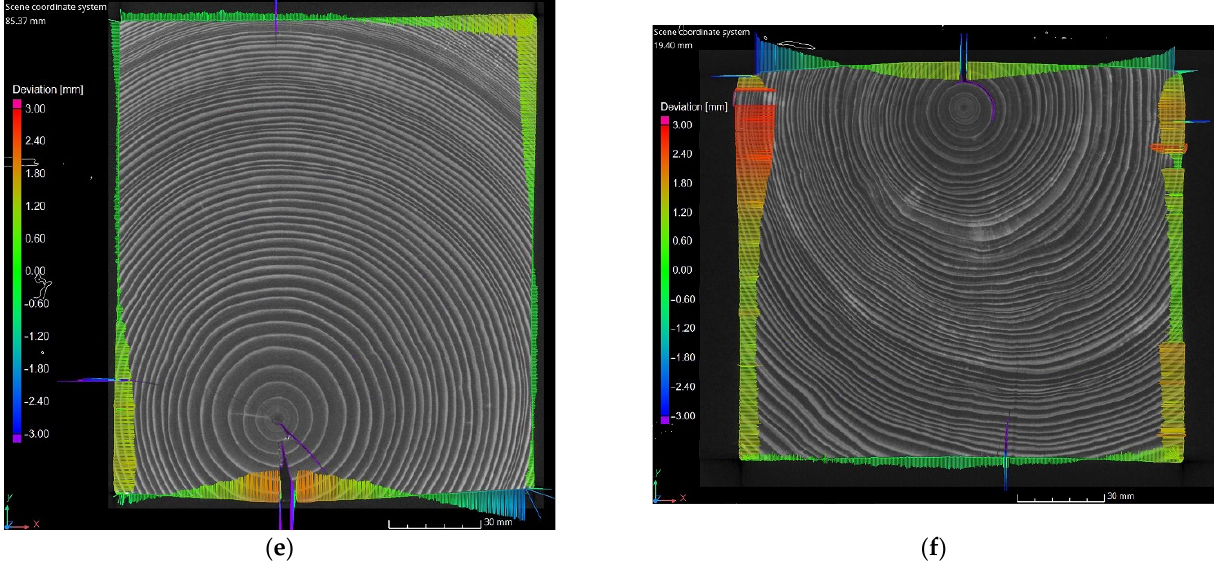
Figure 6. Bar charts of the deviations of the selected samples’ cross-sections; ( a ) sample one; ( b ) sample two; ( c ) sample three; ( d ) sample four (larger scale); ( e ) sample five; ( f ) sample six.